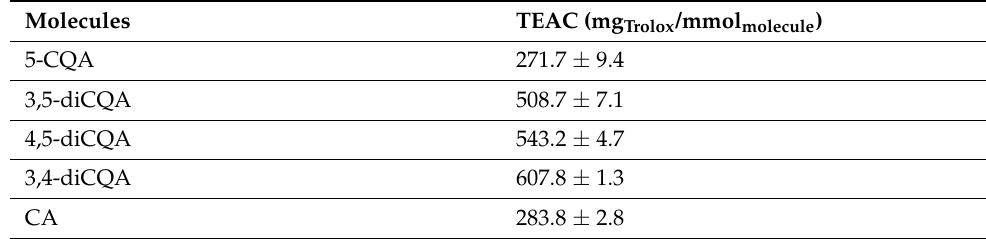
Table 8. Antioxidant activity of standard solution.